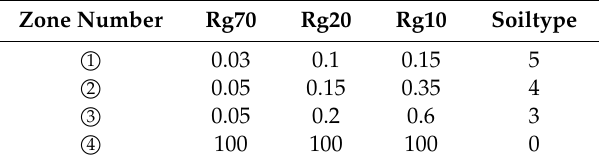
Figure 7. Classification of slope materials and the result of parameter back analysis. Table 1. Numerical simulation parameters of rockfalls in study area.